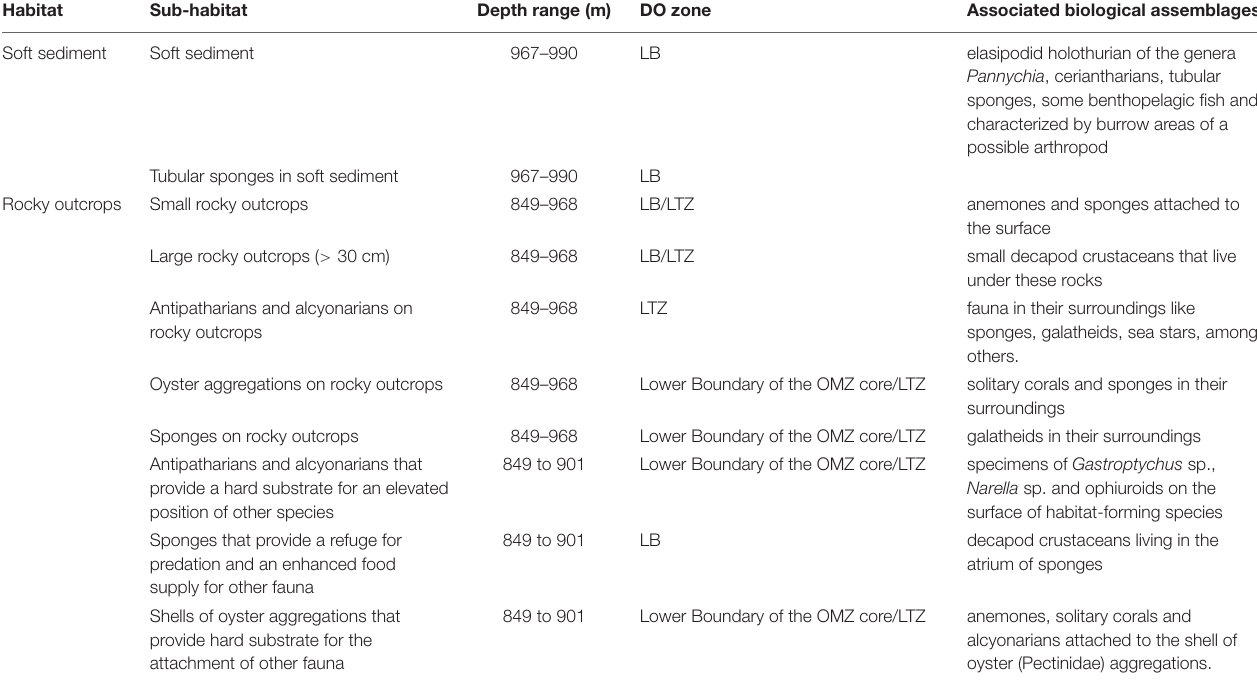
TABLE 4 | Fine-scale epibenthic habitat